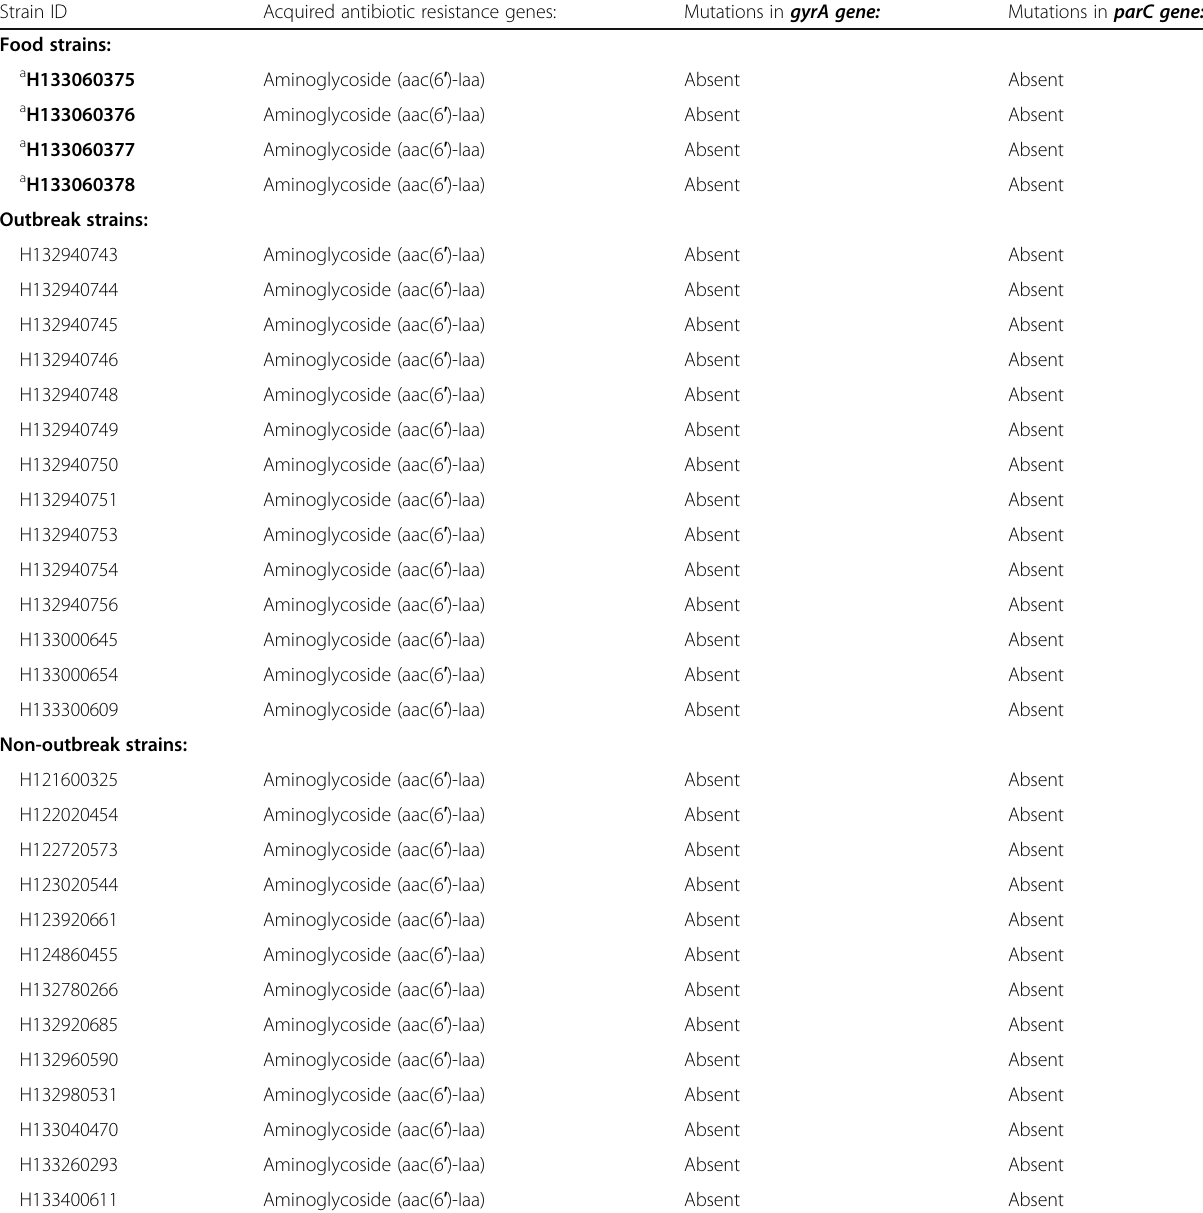
Table 8 In silico analyses results of antimicrobial resistance genes and mutations within all Salmonella Typhimurium strains Strain ID Acquired antibiotic resistance genes: Mutations in gyrA gene: Mutations in parC